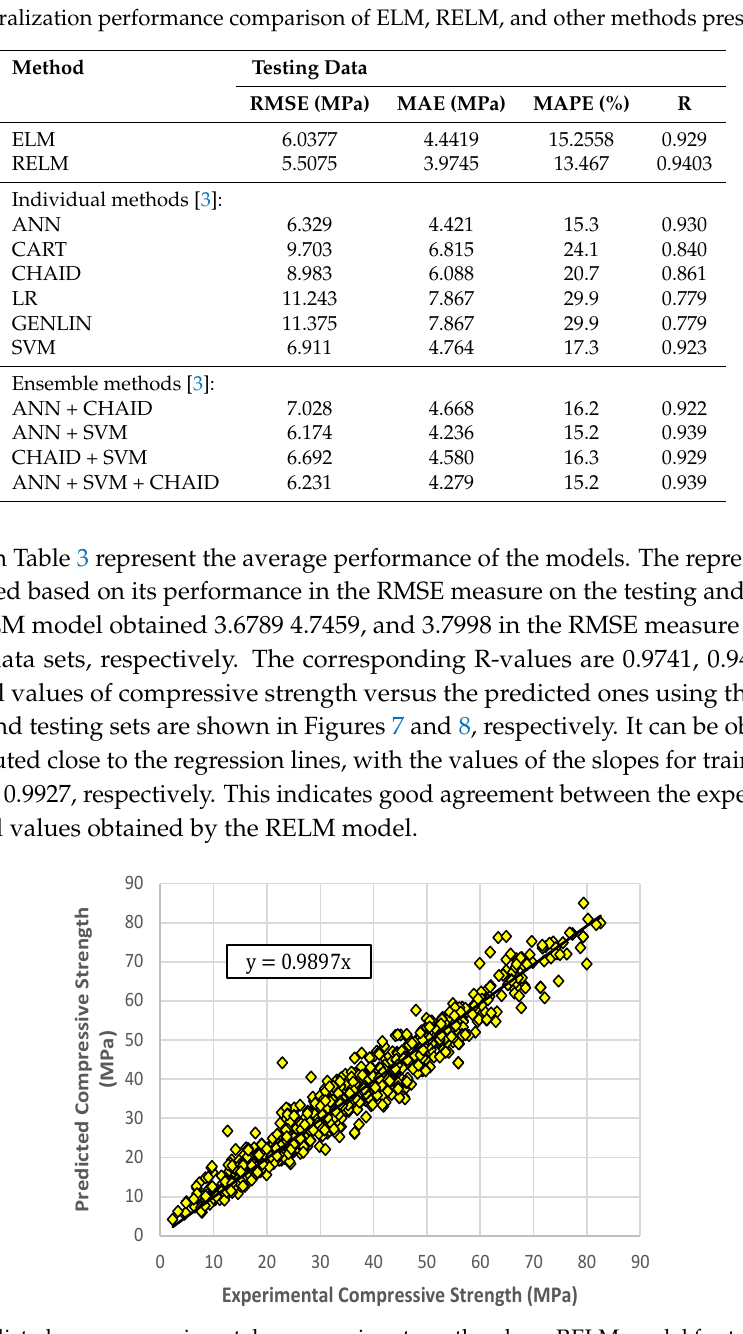
Figure 7. Predicted versus experimental compressive strength values, RELM model for training